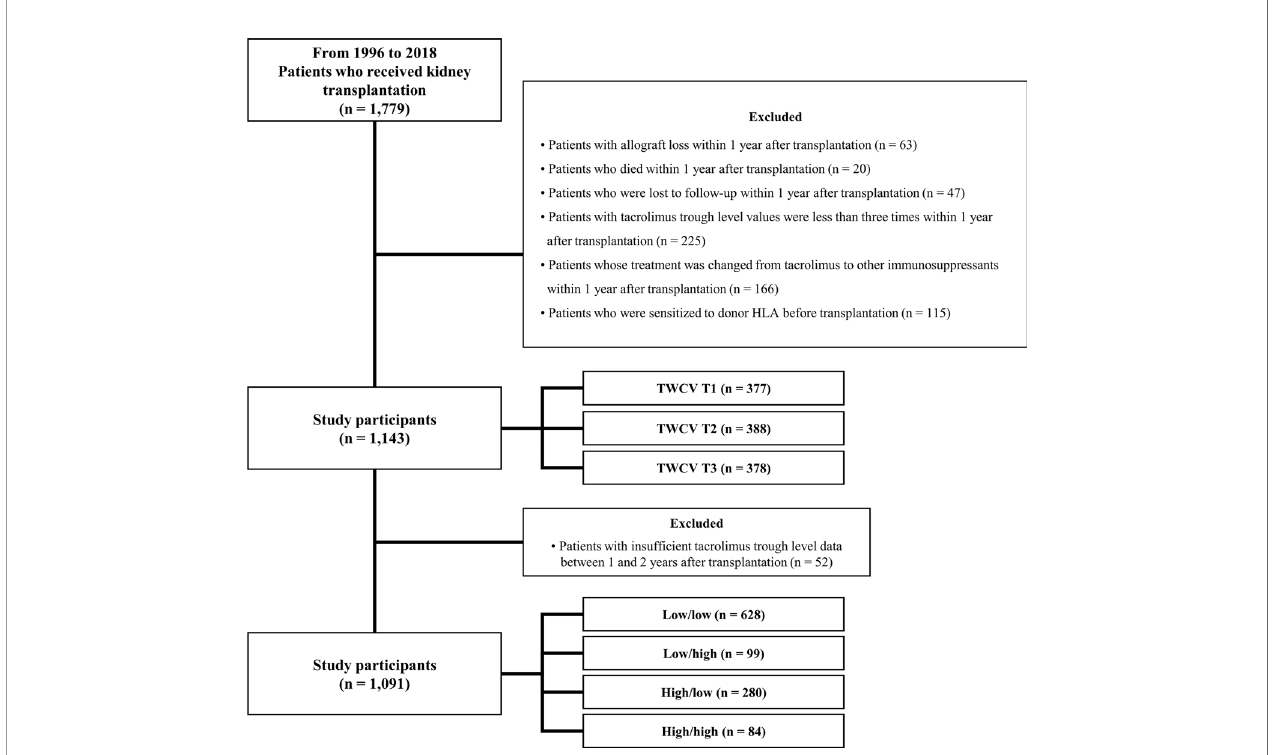
FIGURE 1 | Distribution of patients according to TAC-C0-TWCV. Of 1,779 patients who underwent KT, 636 were excluded. Hence, from January 1996 to December 2018, 1,143 patients were fi nally included in this study. They were classi fi ed into tertile groups according to TAC-C0-TWCV up to post-transplant fi rst year. Fifty-two patients had missing TAC-C0 data during the post-transplant 1 st – 2 nd year. In total, 1,091 patients with complete data up to post-transplant second year were classi fi ed into four groups according to TAC-C0-TWCV during post-transplant 0 – 1 st and 1 st – 2 nd years. HLA, human leukocyte antigen; KT, kidney transplantation; TAC-C0, tacrolimus trough level; TWCV, time-weighted coef fi cient